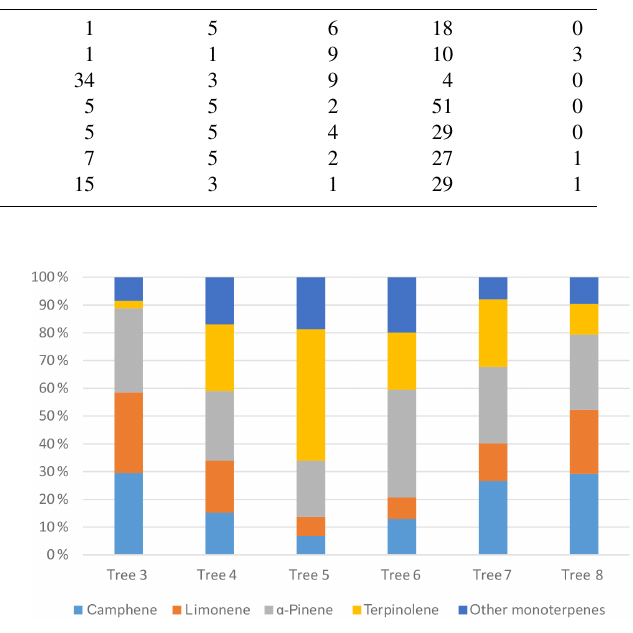
Figure 4. Relative abundances of emitted monoterpenes in six dif- ferent spruce individuals on 24 June